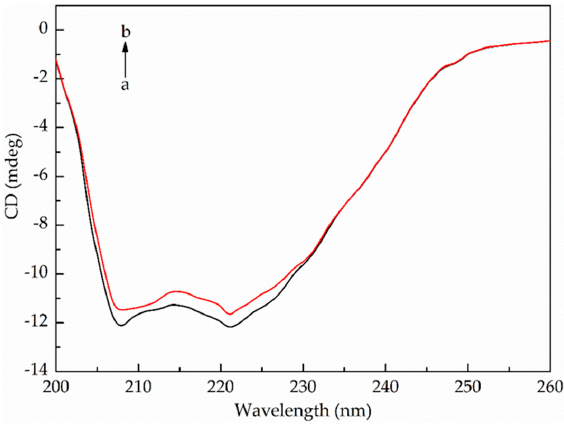
Figure 7. CD spectra of CAT in the absence and presence of 2-MT. Conditions: CAT: 1 × 10 − 7 mol·L − 1 ; Table 3. Effects of 2-MT on the proportion of secondary structural elements in CAT at 291 K. Molar Ratio